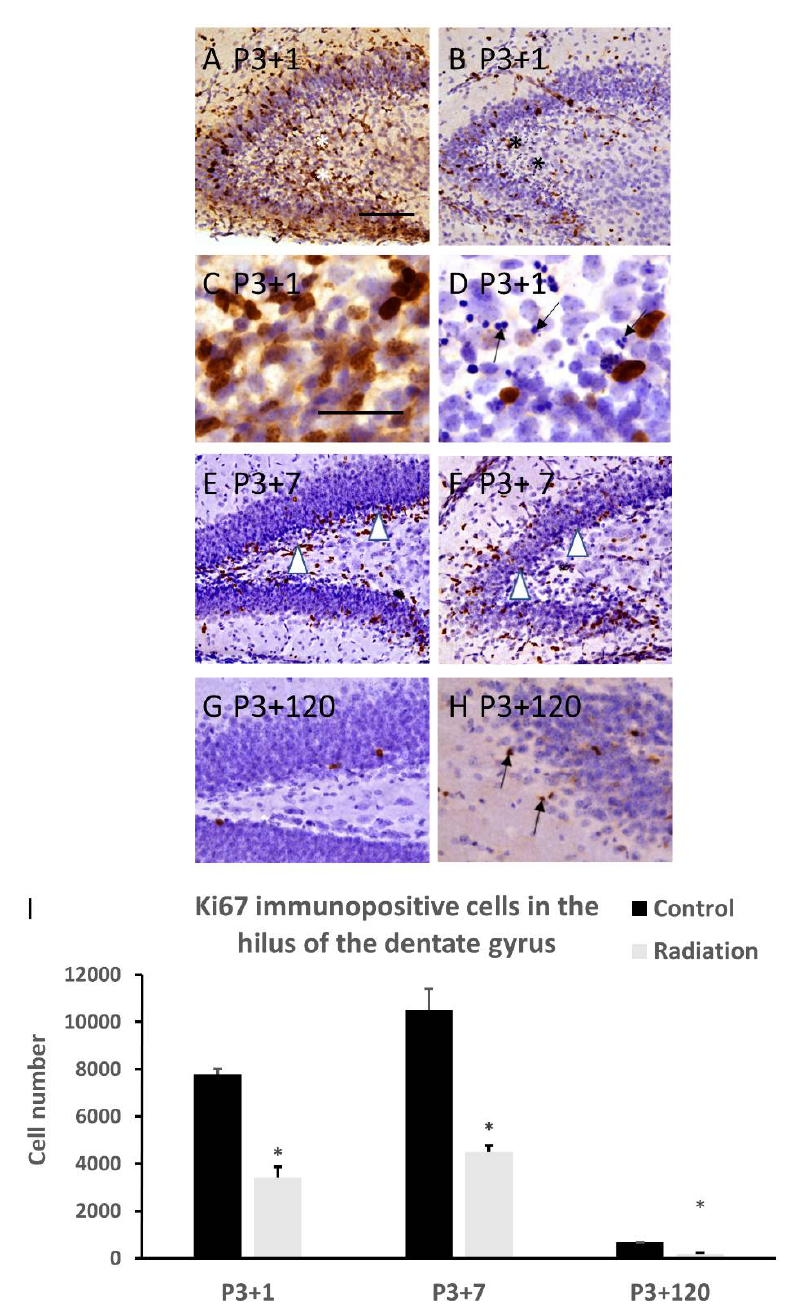
Figure 3. Ki67 immunostaining shows that γ -irradiation with 5Gy at postnatal day 3 induced a significant reduction in Ki67 immunopositive cells in the hilus of the dentate gyrus, including the subgranular zone (asterisks), at 1 ( B , D compared to ( A ), ( C ) in the control, ( C , D ) are magnified figures from ( A , B ), respectively, ( I )) (arrows in ( D ) indicate apoptotic bodies), 7 ( F compared to ( E ) in the control, white arrowheads indicate Ki67 immunopositive cells, ( I )), and 120 (( H ) compared to ( G ) in the control, I ) days after radiation exposure. Aberrant Ki67 immunopositive cells appeared in the molecular layer of the dentate gyrus at 120 days after radiation exposure (arrow in ( H )) ( n = 5). * p < 0.05 vs. respective control. Scale bar =100 μm in ( A ) applies to ( B , E – H ). Scale bar = 50 μm in C applies to ( D ).